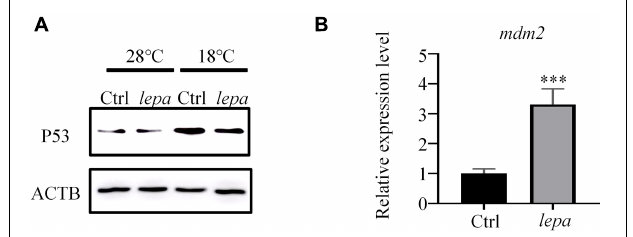
FIGURE 7 | Decreased p53 expression level and enhanced mdm2 expression in ZFL cells under cold temperature. (A) Western blot analysis of the protein expression level of P53 in the cell lysates of the DM-lepa over-expression group and the control group cells. (B) A qRT-PCR assay of MDM-2/mdm2 in control and DM-lepa transfected cells. The results are presented as mean ± SD ( n = 3), ∗∗∗ P < 0.001.